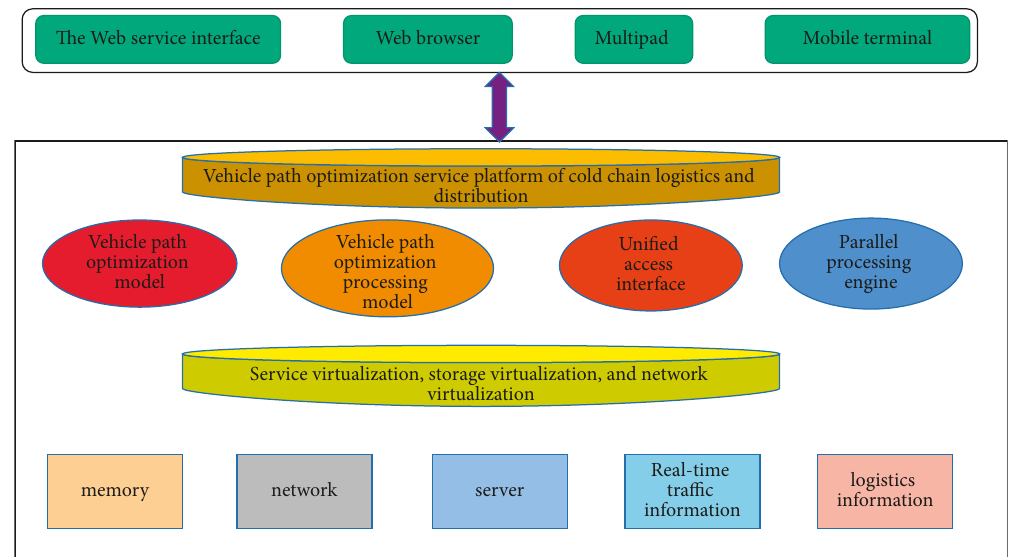
Figure 2: Vehicle routing optimization architecture of cold chain logistics distribution based on cloud